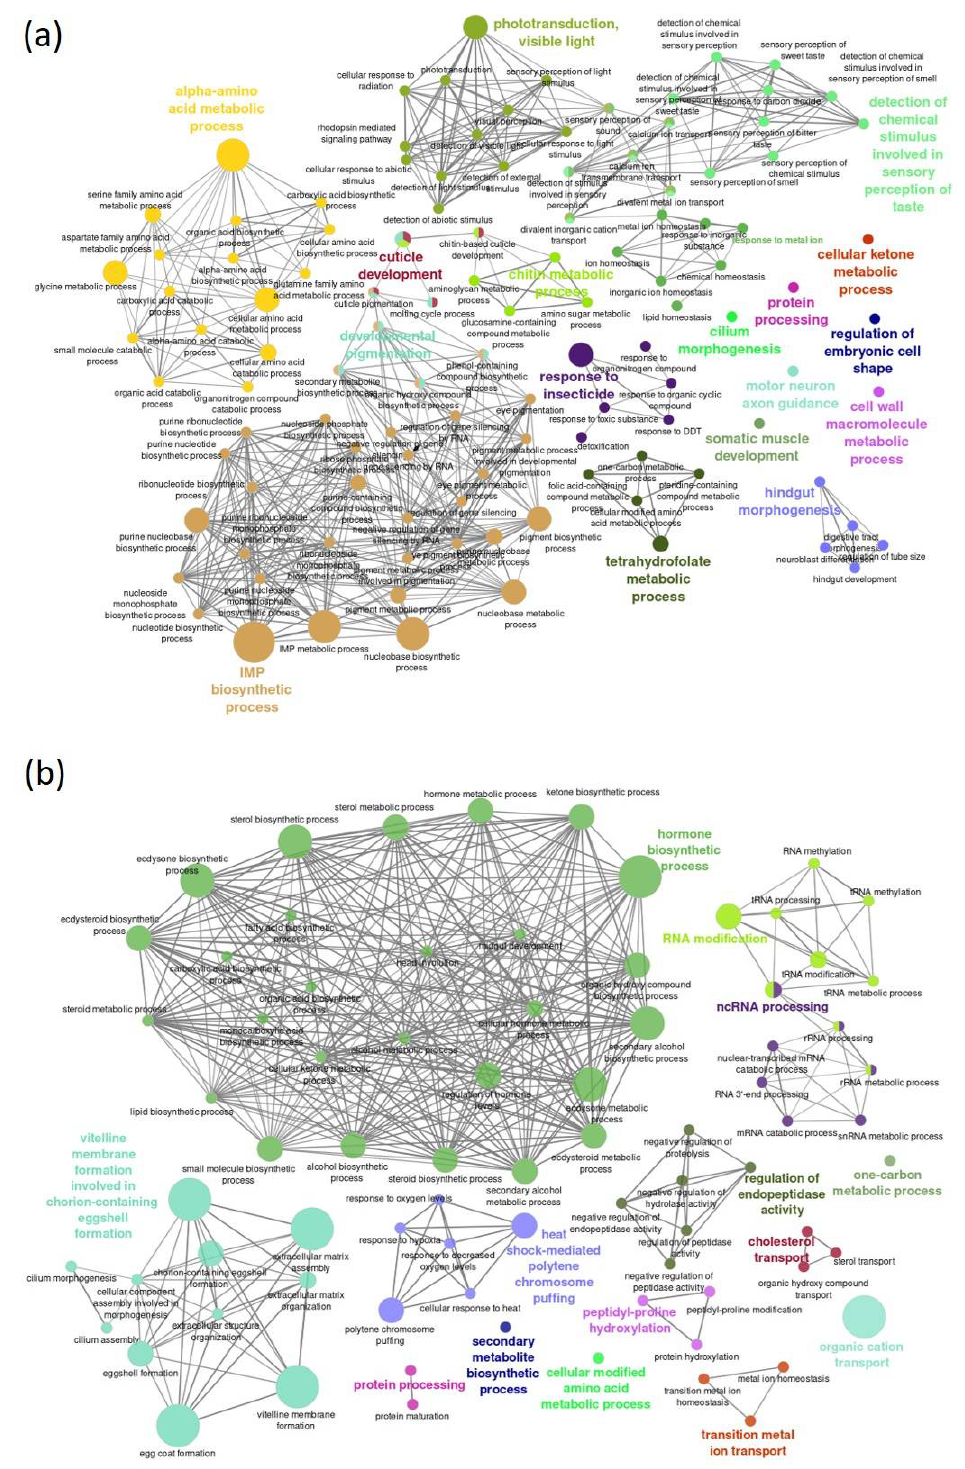
Figure 6. Functional network analysis of upregulated ( a ) and downregulated ( b ) genes of Drosophila with the habanero-pepper diet. The genes are functionally grouped in terms with nodes linked based on their kappa score (≥0.3); only the label of the most significant term per group is shown.